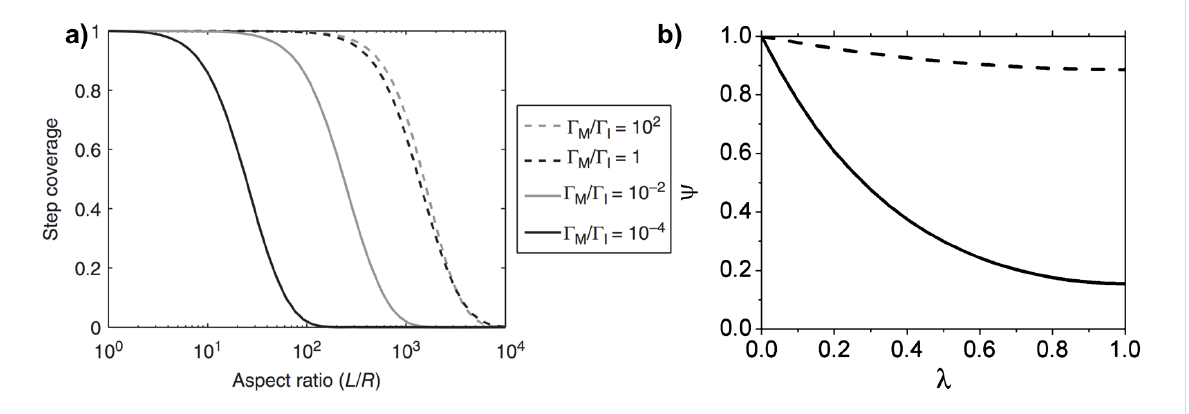
Figure 5: a) Step coverage as function of aspect ratio and ratio of sticking coefficients from numerical solutions of Equation 6. b) Concentration profile of perfluorodecyl acrylate (solid line) and divinyl benzene (dashed line) down a pore. a) Reprinted with permission from [1], copyright 2015 John Wiley and Sons. b) Reprinted with permission from [3], copyright 2011 American Chemical